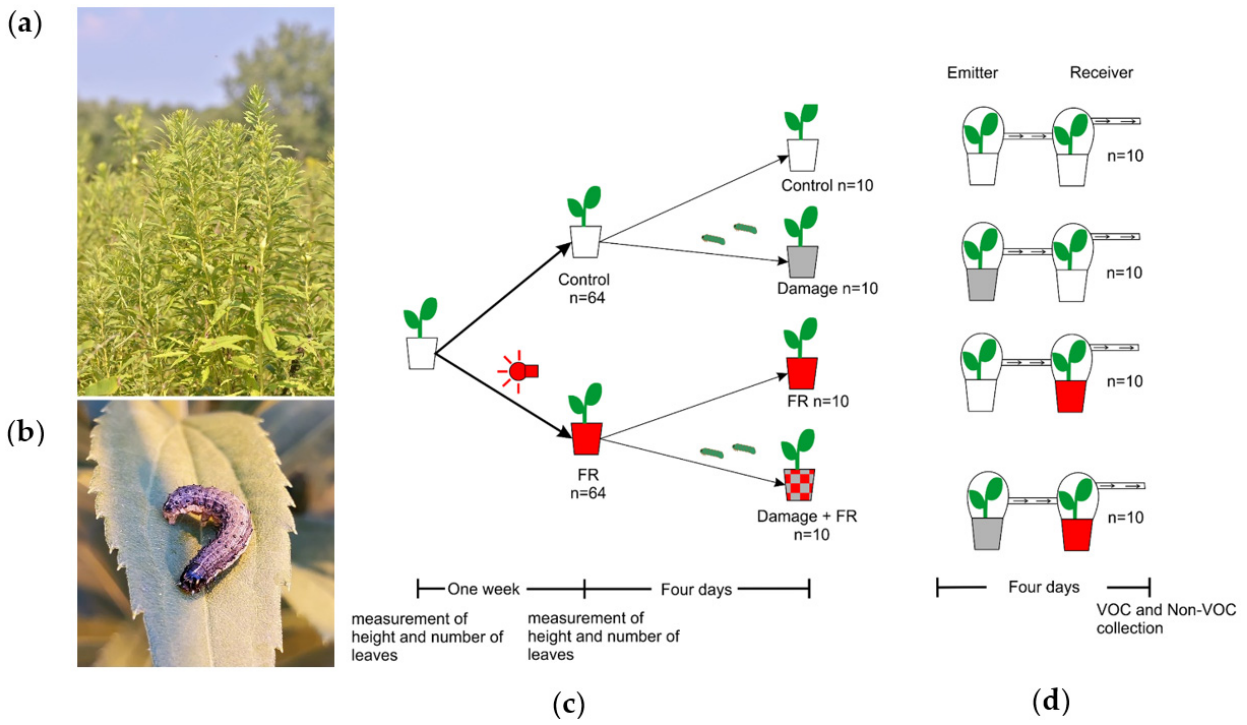
Figure 1. Experimental system. ( a ) Tall goldenrod, Solidago altissima, in dense early succession stands. ( b ) Fall Armyworm, Spodoptera frugiperda ( Noctuidae: Lepidoptera ) , a generalist herbivore on S. altissima . ( c ) Scheme showing the sequence of treatments of Solidago altissima plants in the experiments. Plants were divided into two groups; one was exposed to supplemental far-red (FR) light and the other was kept as a control (ambient light). Then, half of the plants in each treatment were damaged for four days by two S. frugiperda larvae in L3. ( d ) Plants in the supplemented FR light and control treatments were set up to receive volatile organic compounds (VOC) from plants that were damaged by S. frugiperda for four days or from control plants that received no